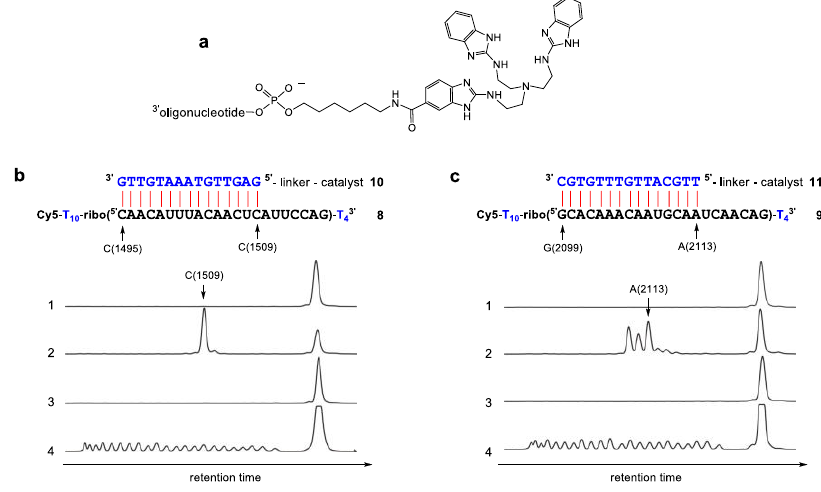
Figure 1. Cleavage of model RNAs. ( a ) Structure of the linker-catalyst part of conjugates 10 and 11 ; ( b ) reaction of RNA 8 and conjugate 10 ; ( c ) reaction of RNA 9 and conjugate 11 . Lanes 1: RNAs 8 or 9 before incubation. Lanes 2: RNAs 8 or 9 after incubation with complementary conjugates 10 and 11 , respectively (150 nM of RNA, 3 µM of conjugate, 50 mM Tris buffer (pH 8.0), 37 °C, 20 h). Lanes 3: Incubation of the noncomplementary pairs 8 / 11 or 9 / 10 under the same conditions. Lanes 4: Hydrolysis ladders of RNAs 8 and 9 . DNA and RNA nucleotides are shown in blue and black letters, respectively.